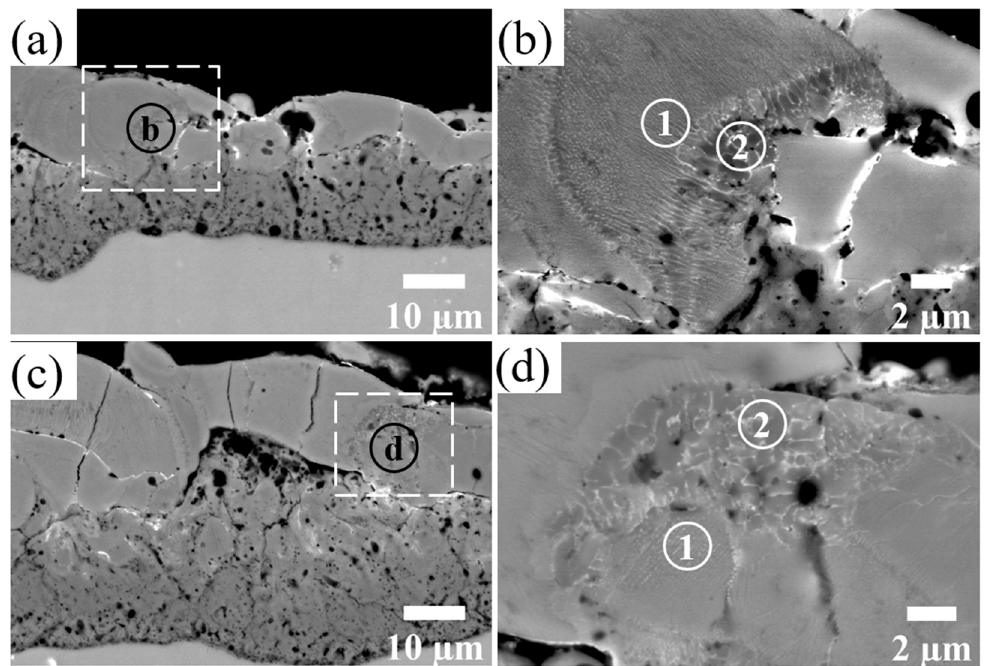
Figure 6. BSD images of the cross-section of the Al 2 O 3 -ZrO 2 coating with different magnifications. Images ( b , d ) show the magnified areas of images ( a , c ), respectively. Regions containing Zr either have lamellar (regions 1) or dendritic (regions 2) structures.